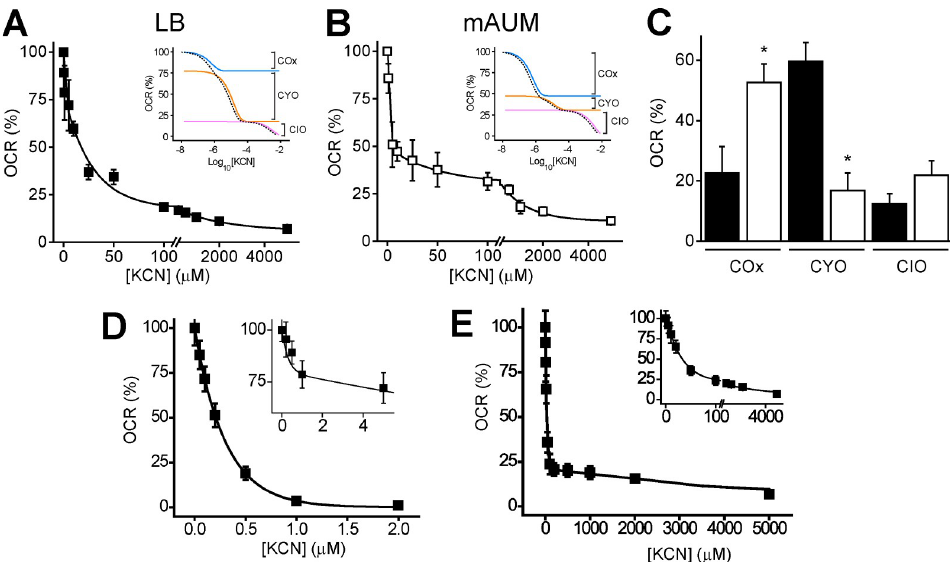
Fig 4. Cyanide titration of respiratory activity. NADH-dependent respiratory activities were measured in LB (A) and mAUM (B) membranes in the presence of different concentrations of KCN (0–5 mM). Titration curves were fitted to the function with three independent Competitive Inhibition Michaelis-Menten components (see Materials and Methods). The first component ( K iapp < 1 μ M) was assigned as COx, the second component ( K iapp 10 μ M) was assigned as CYO and the third component ( K 2.5 mM) was assigned as CIO. The activities ( Vmax ) of these components in LB iapp (black bar) and mAUM (white bar) are compared in panel C. Bars represent mean ± S.D. n � 3. � , p < 0.01 after t test. Insets in panels A and B show the expected titration curves of COx (blue), CYO (orange) and CIO (pink) oxidases, and the addition of the three components (dashed black line). The colored lines were slightly moved to the right for clarity. D) Titration of the Ascorbate /TMPD respiratory activity of LB membranes. The fitting line was obtained with a single- component kinetic model. The inset shows a magnification into the 0–5 μ M KCN region of panel A. E) KCN titration of the ubiquinol-dependent respiratory activity in the presence of 1 μ M antimycin A, which inhibits cytochrome bc 1 . The values of 15 μ M and 3 mM. The inset shows a fitting line was obtained with a two-component kinetic model, with K iapp replotting of the data with a break from 100–200 μ M